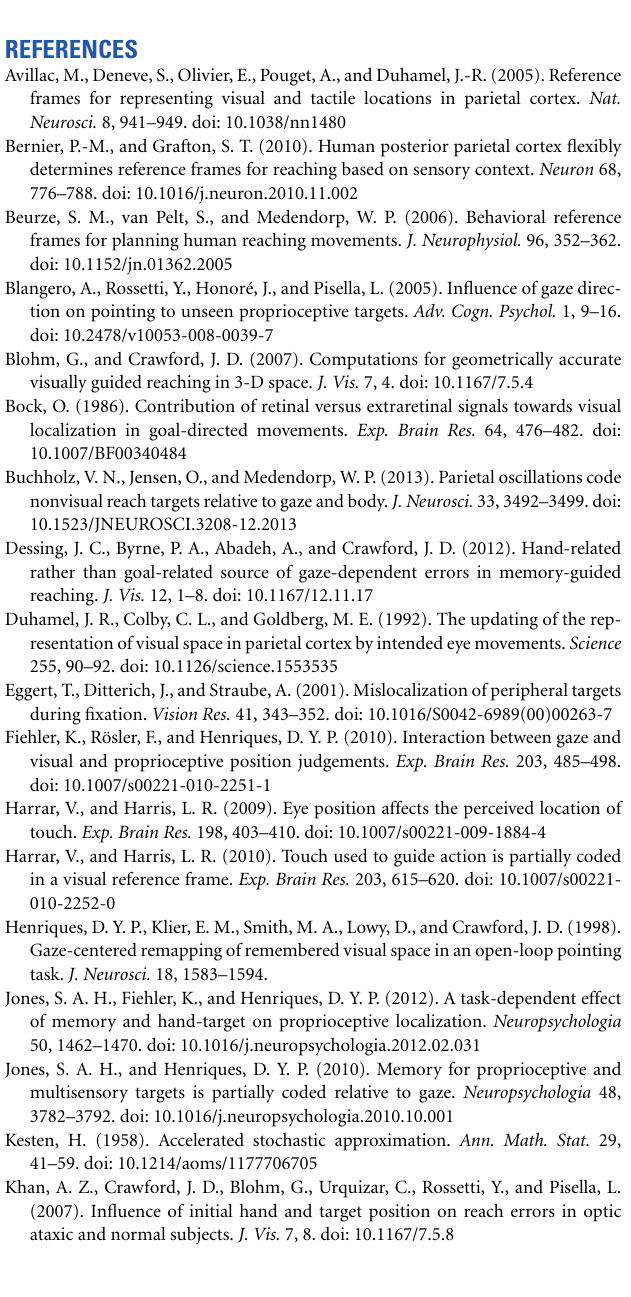
Supplementary Figure 1 | Psychometric functions of one exemplary subject for the fixedand shifted-gaze